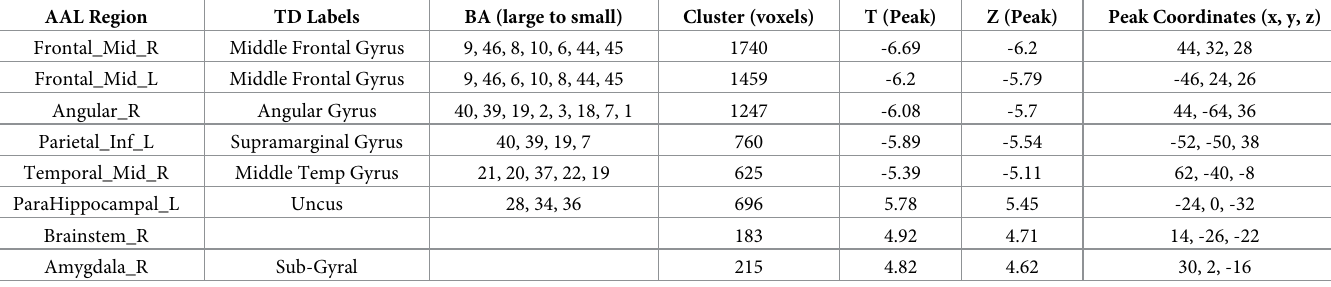
Table 2. Significantly changed metabolic clusters corresponding anatomic/functional